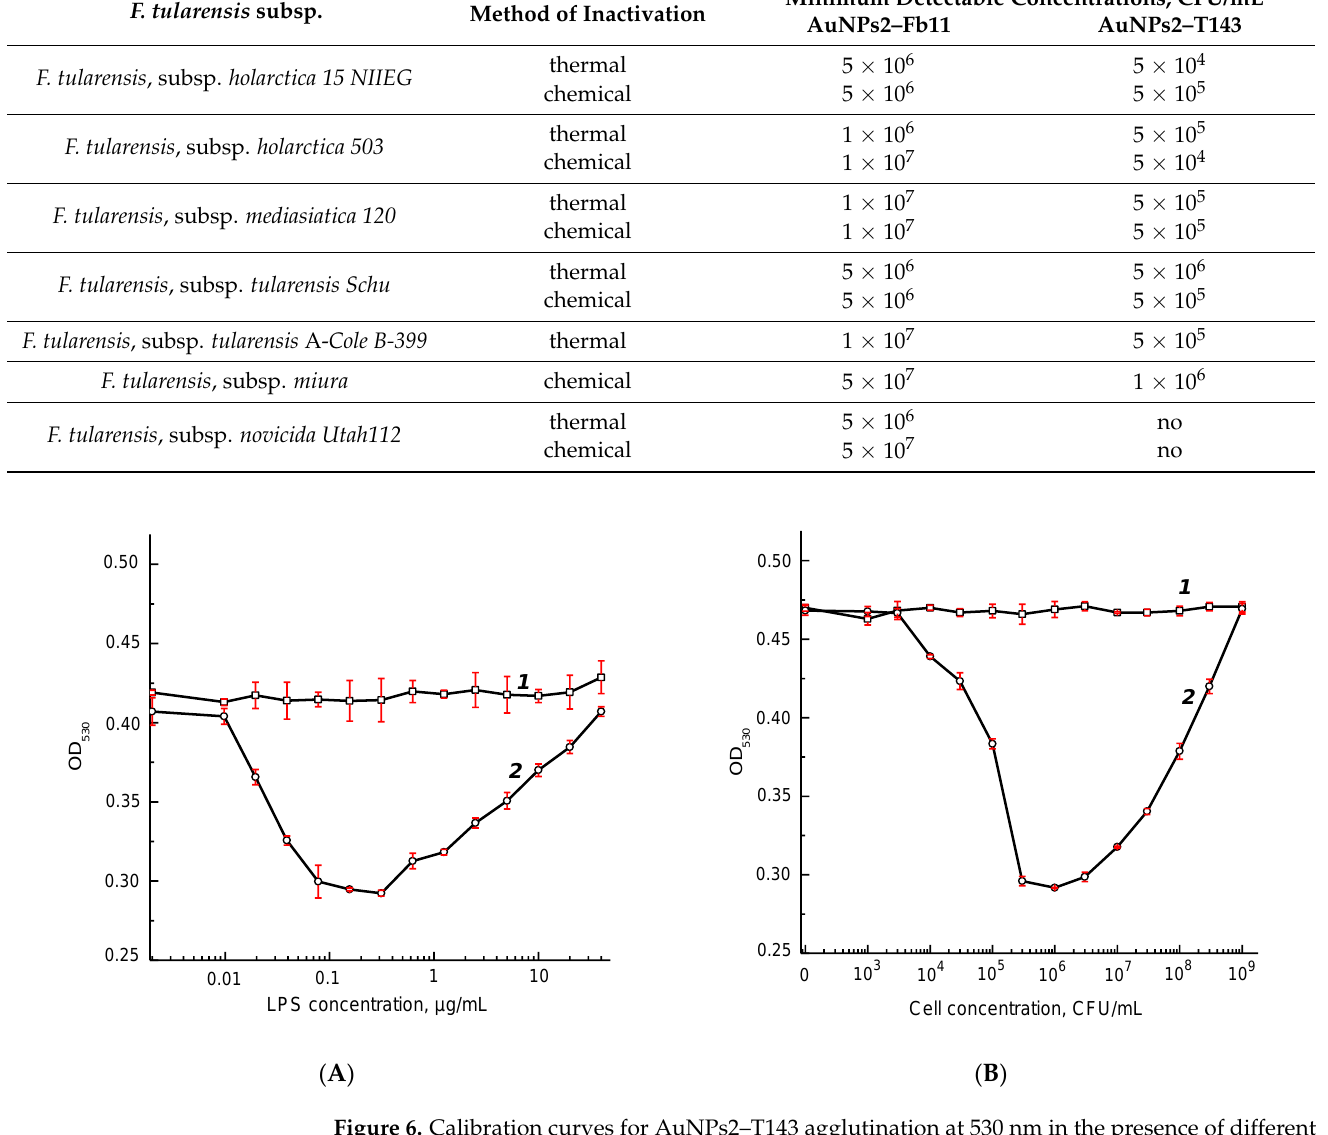
Table 6. OD 530 values in water samples spiked with F. tularensis subsp. holarctica 15 NIIEG cells at concentrations of 10 8 , 10 7 , 10 6 , and 10 5 CFU/mL after 1 and 20 min of the agglutination reaction. OD 530 of the Reaction Mixture, Optical Units Cell Concentra- Water Sample tion, CFU/mL